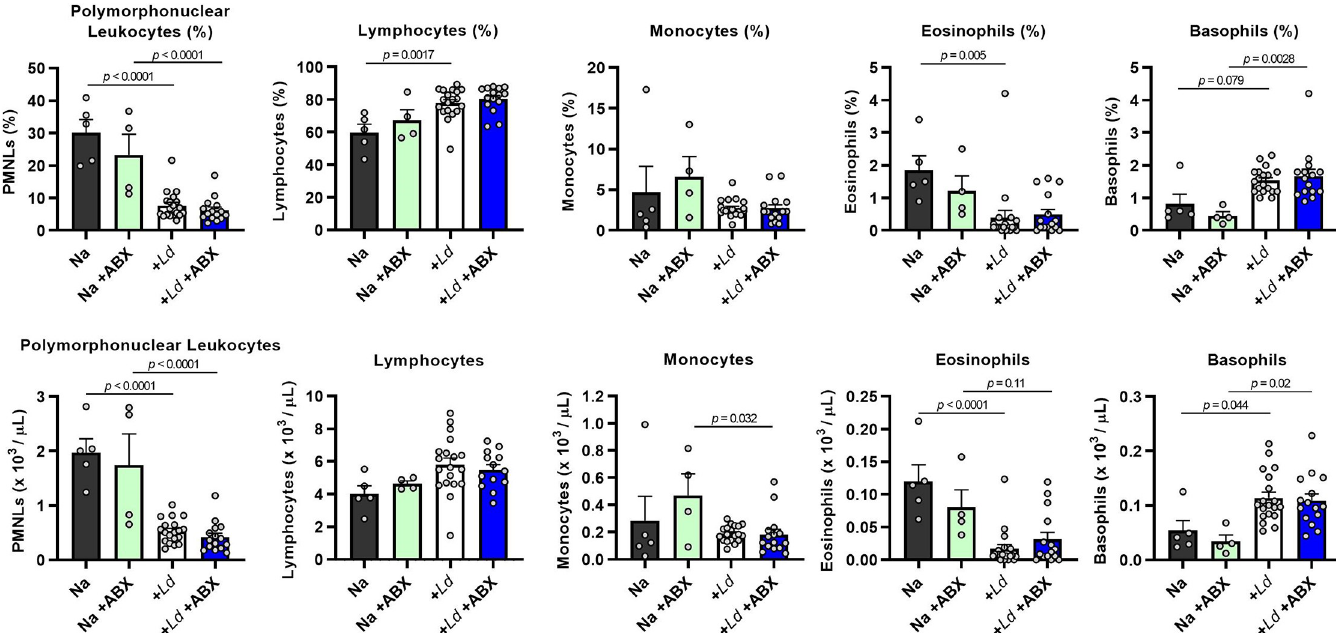
Fig 5. Leukocyte profiles of dysbiotic hamsters infected with L . donovani . Hamsters were maintained on drinking water with or without antibiotic cocktail (ABX) and infected with L . donovani (n = 15–19) and compared with na ï ve (Na) controls (n = 4–5). Data show individual component assays from complete blood counts at 12 weeks post-infection. Groups were compared by one way ANOVA and differences at p < 0.05 are